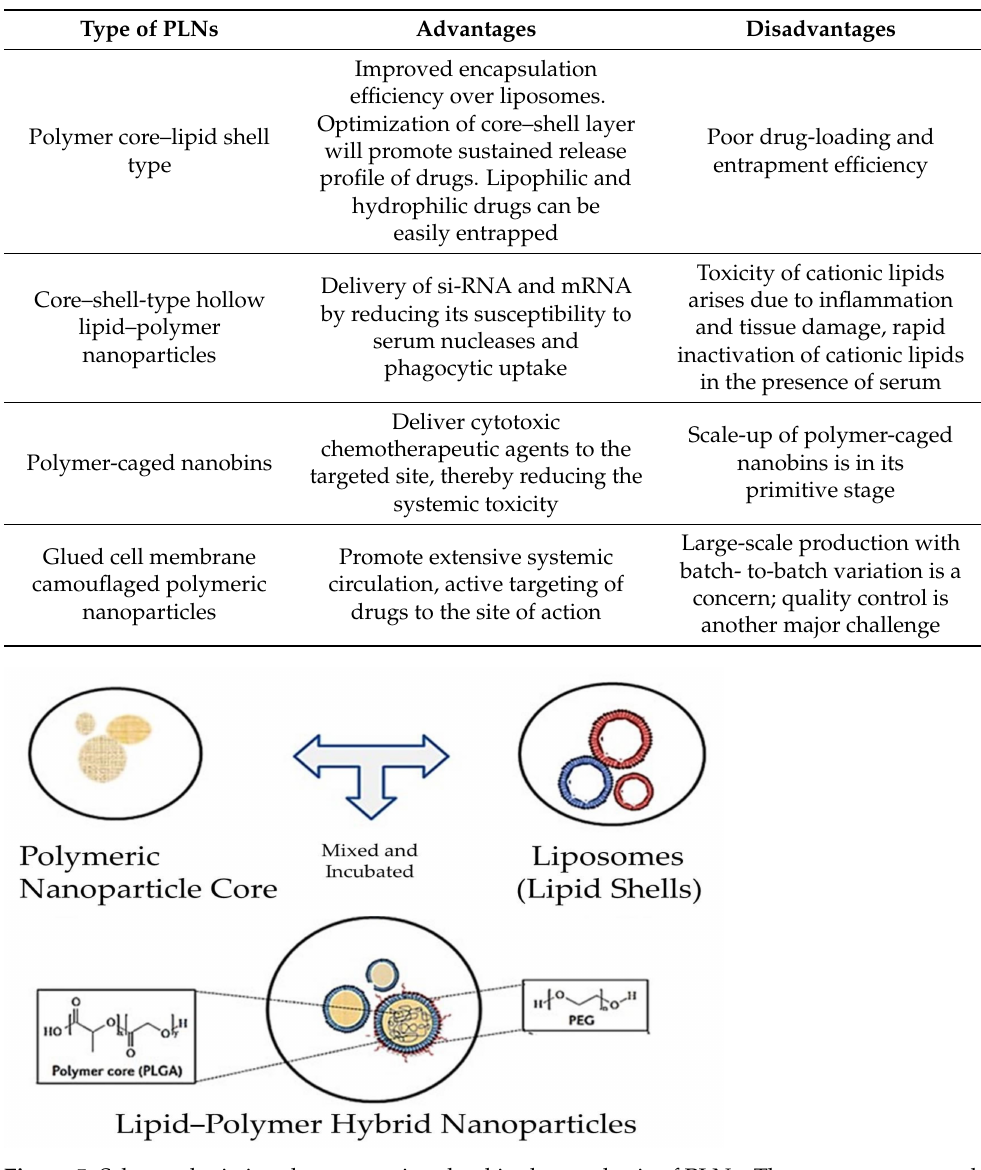
Figure 5. Scheme depicting the process involved in the synthesis of PLNs. The one-step approach involves the direct fusion of all the components, while in the two-step approach, components such as polymeric nanoparticle cores (PNPs) and lipid shells (liposomes) are discretely synthesized and mixed in the following steps. Finally, the PLNs are